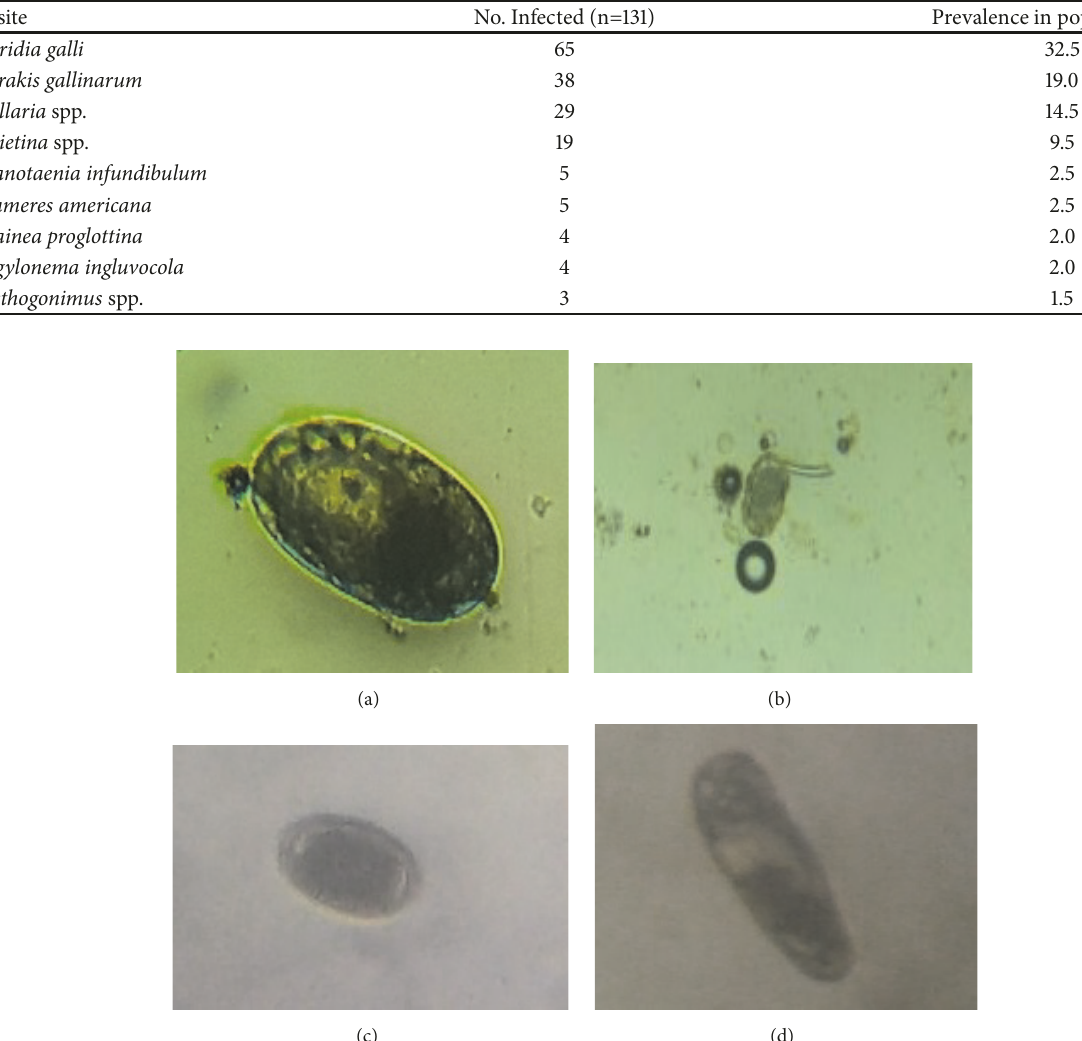
Figure 3: Photographs of some eggs of gastrointestinal helminths of local and exotic breeds of chicken in Pankrono-Kumasi Ghana. (a) Capillaria egg, (b) H. gallinarum , (c) Ascarid egg , and (d) Choanotaenia infundibulum